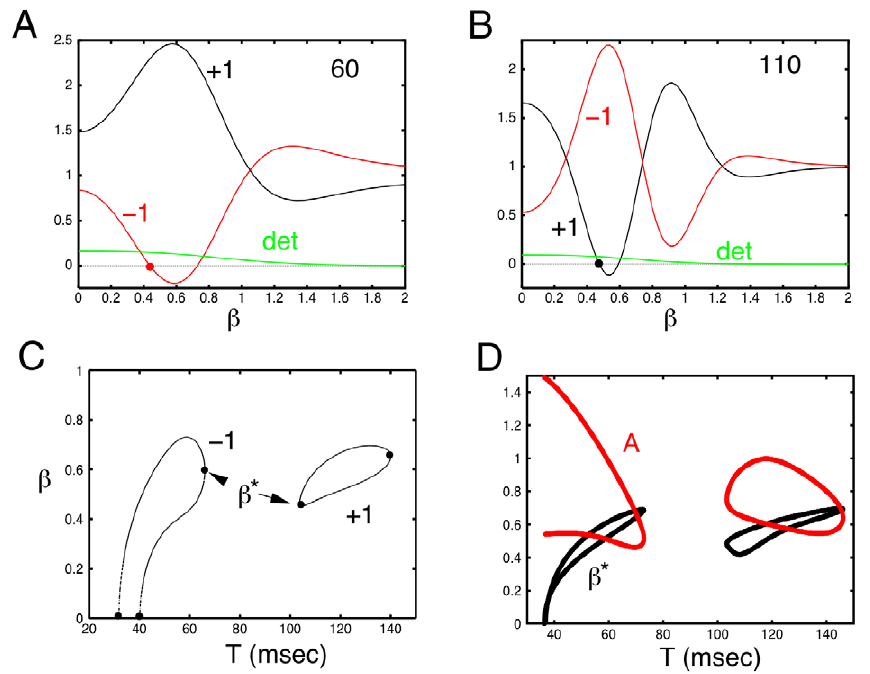
Figure 8. Stability calculation illustrated. (A,B) Values of the determinant (green) and stability conditions for a + 1 (black) and 2 1 (red) Floquet multiplier as the wave-number, b varies. For stability the determinant must be less than 1 and the black and red curves should be positive. (A): 60 msec and (B): 110 msec forcing period. (C) Wave numbers, b where the + 1 curves from A and B cross the zero axis as the forcing period varies. Black dots correspond to local extreme values delineating the edge of stability regions. Inside these domains the spatially uniform oscillation is unstable. (D) Critical region for stability as the amplitude and period vary. Red curves correspond to the amplitudes, A and black to the critical wavenumber, b (cid:3)